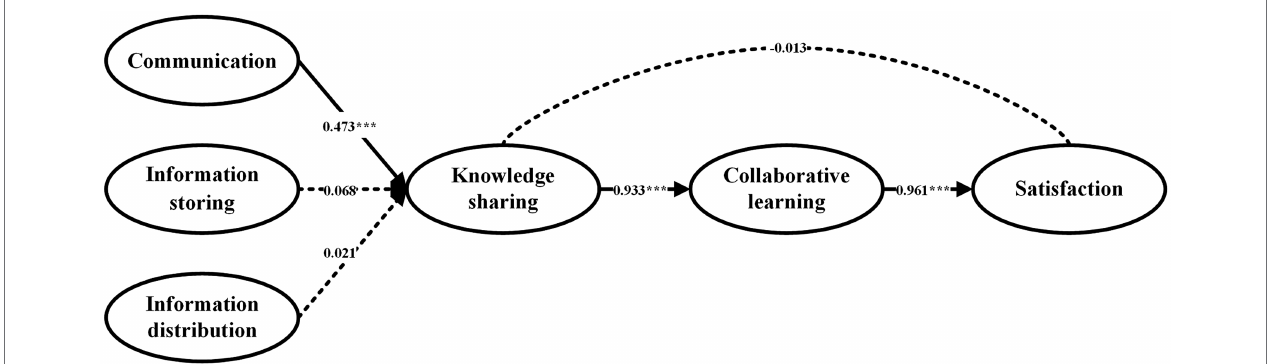
FIGURE 3 | Data analysis results. *** p < 0.001.